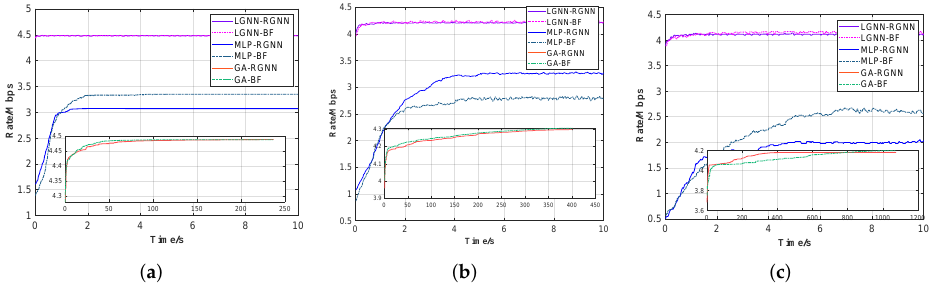
Figure 8. Convergence speed and performance for the different algorithms with a different number of users and UAVs. Because the convergence time of GA-based algorithms is far longer than others, we demonstrate it in a separate figure. ( a ) |V s | = 10, |V u | = 2. ( b ) |V s | = 15, |V u | = 3. ( c ) |V s | = 20, |V u | = 5.